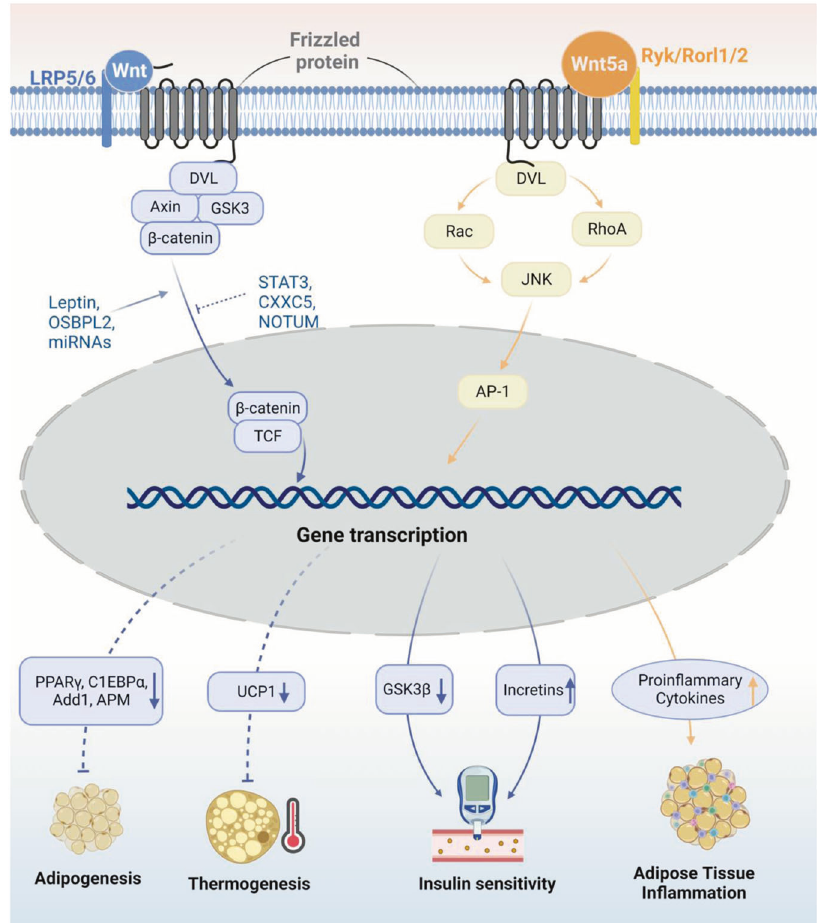
Fig. 4 Wnt/ β -catenin pathways in obesity pathogenesis. In the canonical Wnt pathway, upon activation by Wnt proteins, β -catenin is released and enters the nucleus as a transcription coactivator of TCF to regulate the transcription of target genes. The activation of Wnt/ β -catenin pathway leads to, (1) the supersession of adipogenesis by down-regulating the expression of PPAR γ , C1EBP α , Add1, APM, etc.; (2) the inhibition of BAT-related thermogenesis by down-regulating UCP-1; and (3) the increase of insulin sensitivity by down-regulating GSK3 β expression in CNS while up-regulating incretins within the small intestinal epithelium. The canonical Wnt signaling can be stimulated by factors including leptin, OSBPL2, and miRNAs like miR-23b, miR-148b miR-4269, and miR-4429. It can also be inhibited by JAK/STAT3 pathway, CXXC5, and NOTUM. These factors are all involved in the pathogenesis of obesity by regulating Wnt/ β -catenin signaling pathway. Additionally, Wnt5a, a part of the non-canonical Wnt pathway, induces obesity-associated in fl ammation in WAT in a JNK-dependent manner, which further contributes to the occurrence of insulin resistance in adipose